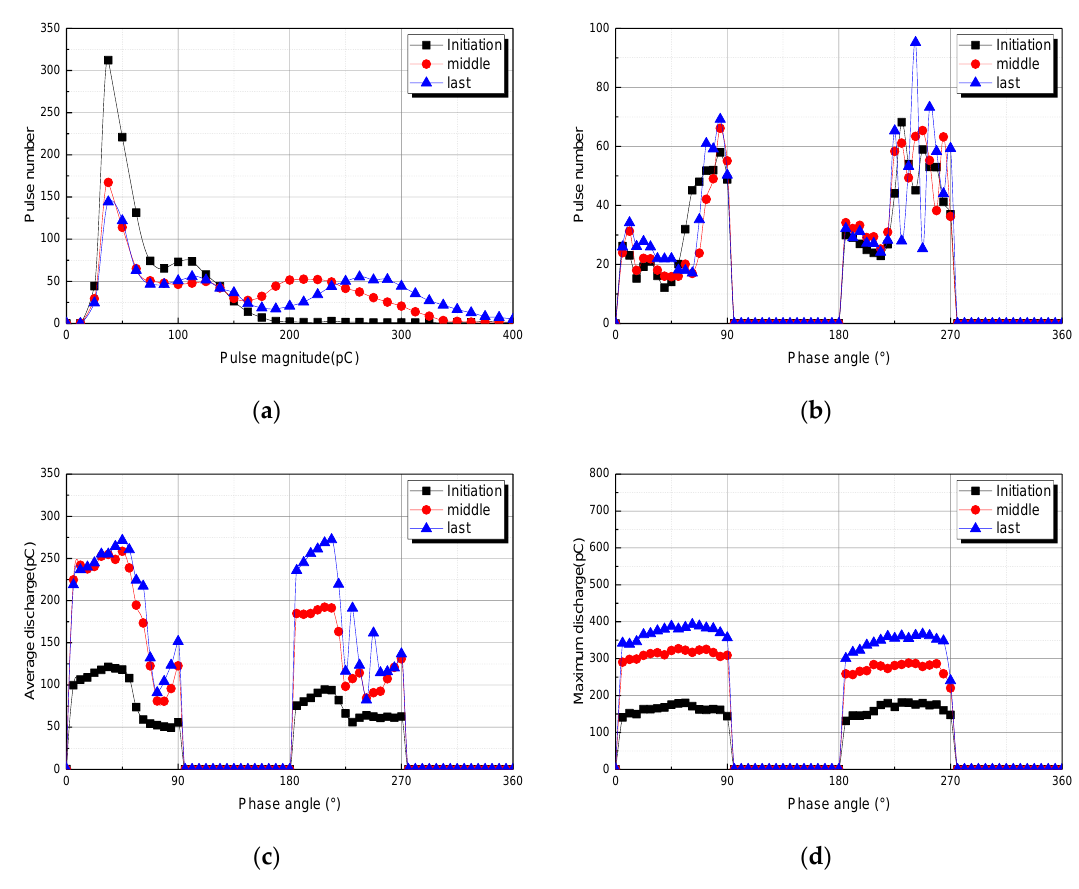
Figure 5. Statistical distributions of PD for tree model 2: ( a ) Hn(q) distribution; ( b ) Hn(Φ) distribution; ( c ) Hq n (Φ) distribution; ( d ) Hq max (Φ) distribution.